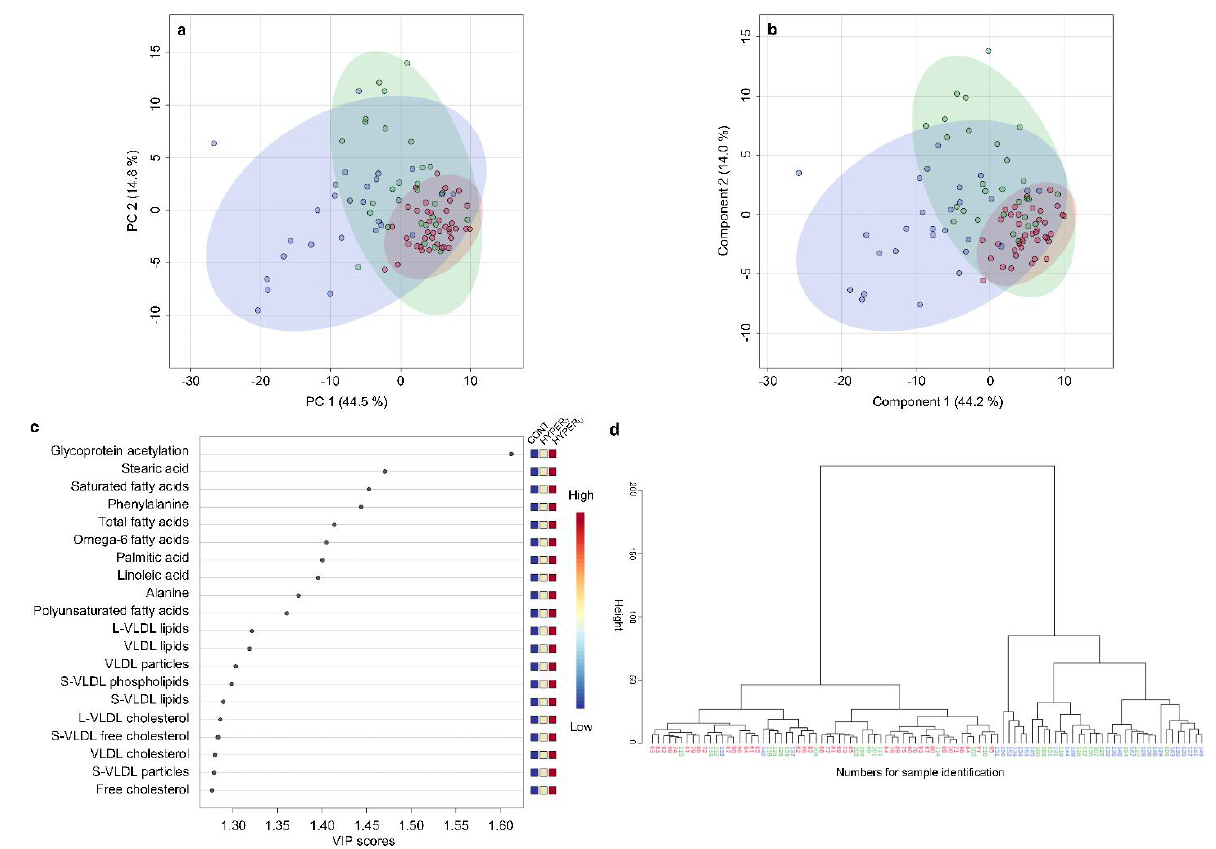
Figure 5. Metabolomic analyses of serum samples from dogs in the groups hyperadrenocorticism untreated (HYPER U , n = 27), hyperadrenocorticism treated (HYPER T , n = 28), and control (CONT, n = 40). ( a ) Scores plots of principal component analysis (PCA) and ( b ) partial least squares-discriminant analysis (PLS-DA) based on metabolomics data between serum samples of dogs in HYPER U (blue), HYPER T (green), and CONT groups (red). Shaded circles represent 95% confidence intervals, while colored dots illustrate individual samples. The axes are labeled by the first and second (principal) components with the percentages of variance of the data explained by that component in parentheses. ( c ) Variable importance in projection (VIP) scores of component 1 of the PLS-DA identifies the top 20 discriminating parameters in descending order of importance. The colored legend on the right indicates the relative abundance of variables, with red and blue indicating high and low values, respectively, while beige illustrates neutral values. ( d ) Dendrogram of hierarchical cluster analysis of serum metabolomic results from canine samples in either HYPER U (blue), HYPER T (green), or the CONT group (red). Each number on the x-axis reflects one serum sample. The y-axis shows the similarity levels expressed as Euclidean distances. Horizontal and vertical lines depict clustering of samples and differences in the distances, respectively.